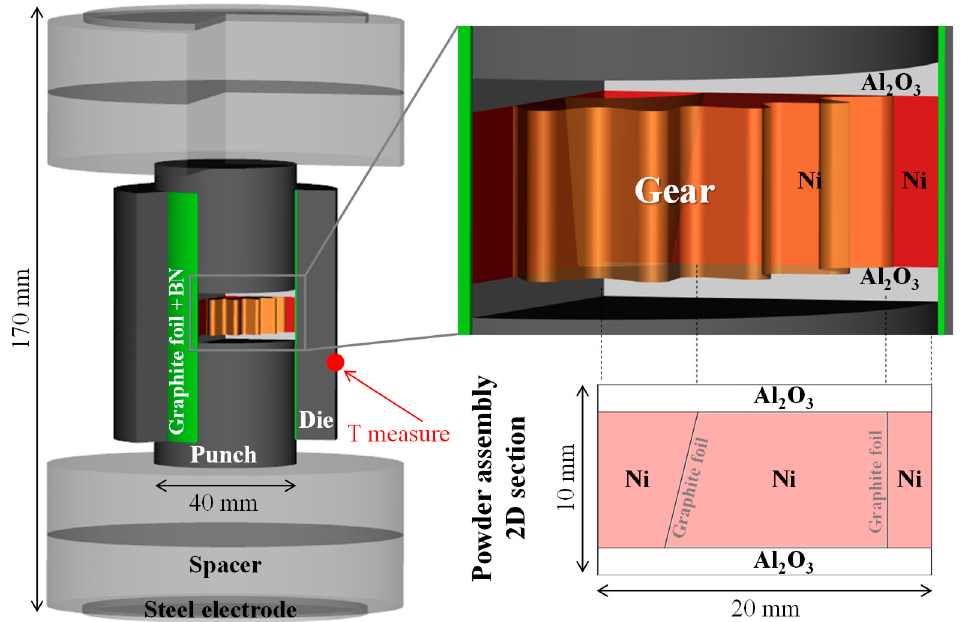
Figure 2. Energy efficient spark plasma sintering configuration with: the overall graphite tooling column; and inside the powder area, the details of the “controllable interface method” for creating the nickel gear shape with graphite foil and alumina